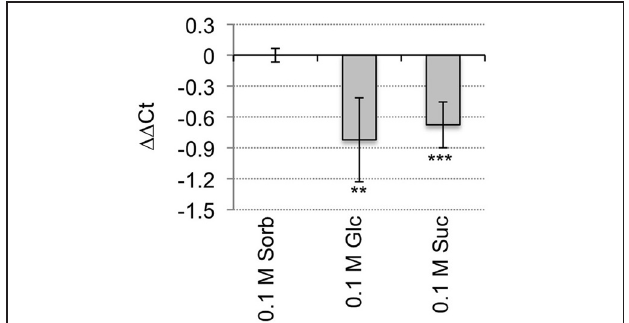
FIGURE 1 | HAC1 expression is repressed by sugars. Wild-type Arabidopsis seeds were surface sterilized and then incubated in the dark at 4 ◦ C for 3 days prior to being sown on nytex screens on Petri plates containing solid minimal Arabidopsis media. The seeds were incubated under continuous light at room temperature for 20h, and then the nytex screens and seeds were transferred to Petri plates containing Arabidopsis minimal media supplemented with 0.1M sorbitol (Sorb), Glc, or Suc. After an additional 12–13h, seeds were harvested, followed by isolation of RNA. The RNA was then used for qRT-PCR analysis. The transcript levels of ACT7 and UBQ6 were determined and the geometric means of their Ct used to normalize transcript levels. Transcript levels are expressed as (cid:2)(cid:2) Ct. − (cid:2) Ct (cid:2)(cid:2) Ct = (cid:2) Ct HAC1 onsorbitol HAC1 onindicatedmedia